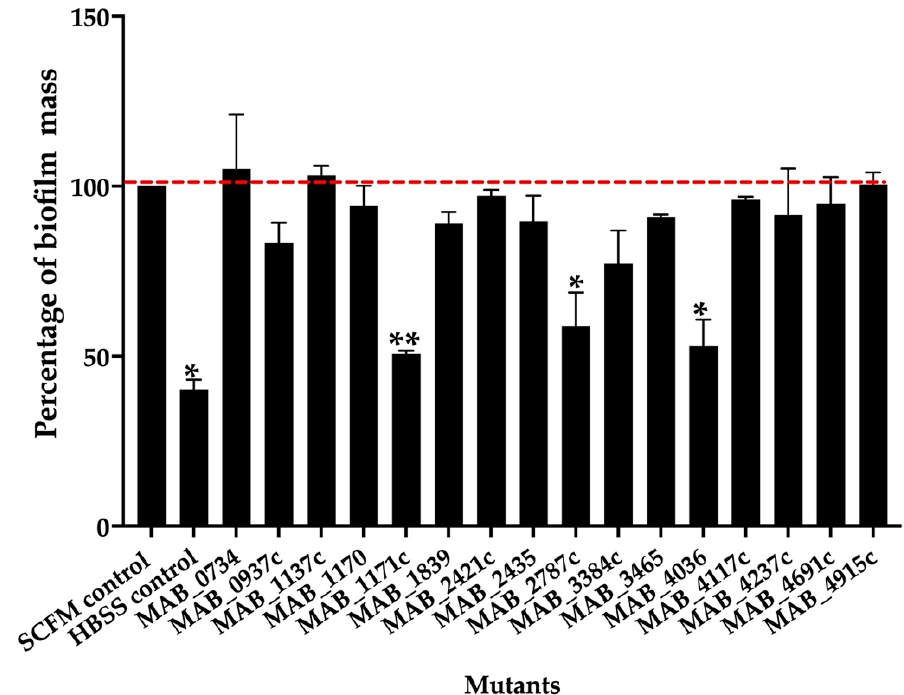
Figure 2. The percentage of biofilm mass for MAB mutants belonging to the surface transport systems. The biofilm mass of the MAB wild-type and transposon mutants were quantified at day 7 with 0.1% crystal violet staining and solubilization of 30% acetic acid, and the measurements were recorded at OD 570 . The percentage of biofilm formation was normalized to the positive control, representing the MAB 19977 biofilm mass in SCFM (dashed red line), while the MAB 19977 biofilm mass in HBSS represents the negative control. Data represents the mean ± SD of wells assayed in duplicate and with three biological replicates. Significant differences were observed between the positive biofilm of MAB 19977 in SCFM and the negative control in HBSS (* p < 0.05), MAB_1171c (** p < 0.01), MAB_2787c (* p < 0.05), and MAB_4036 (* p < 0.05).